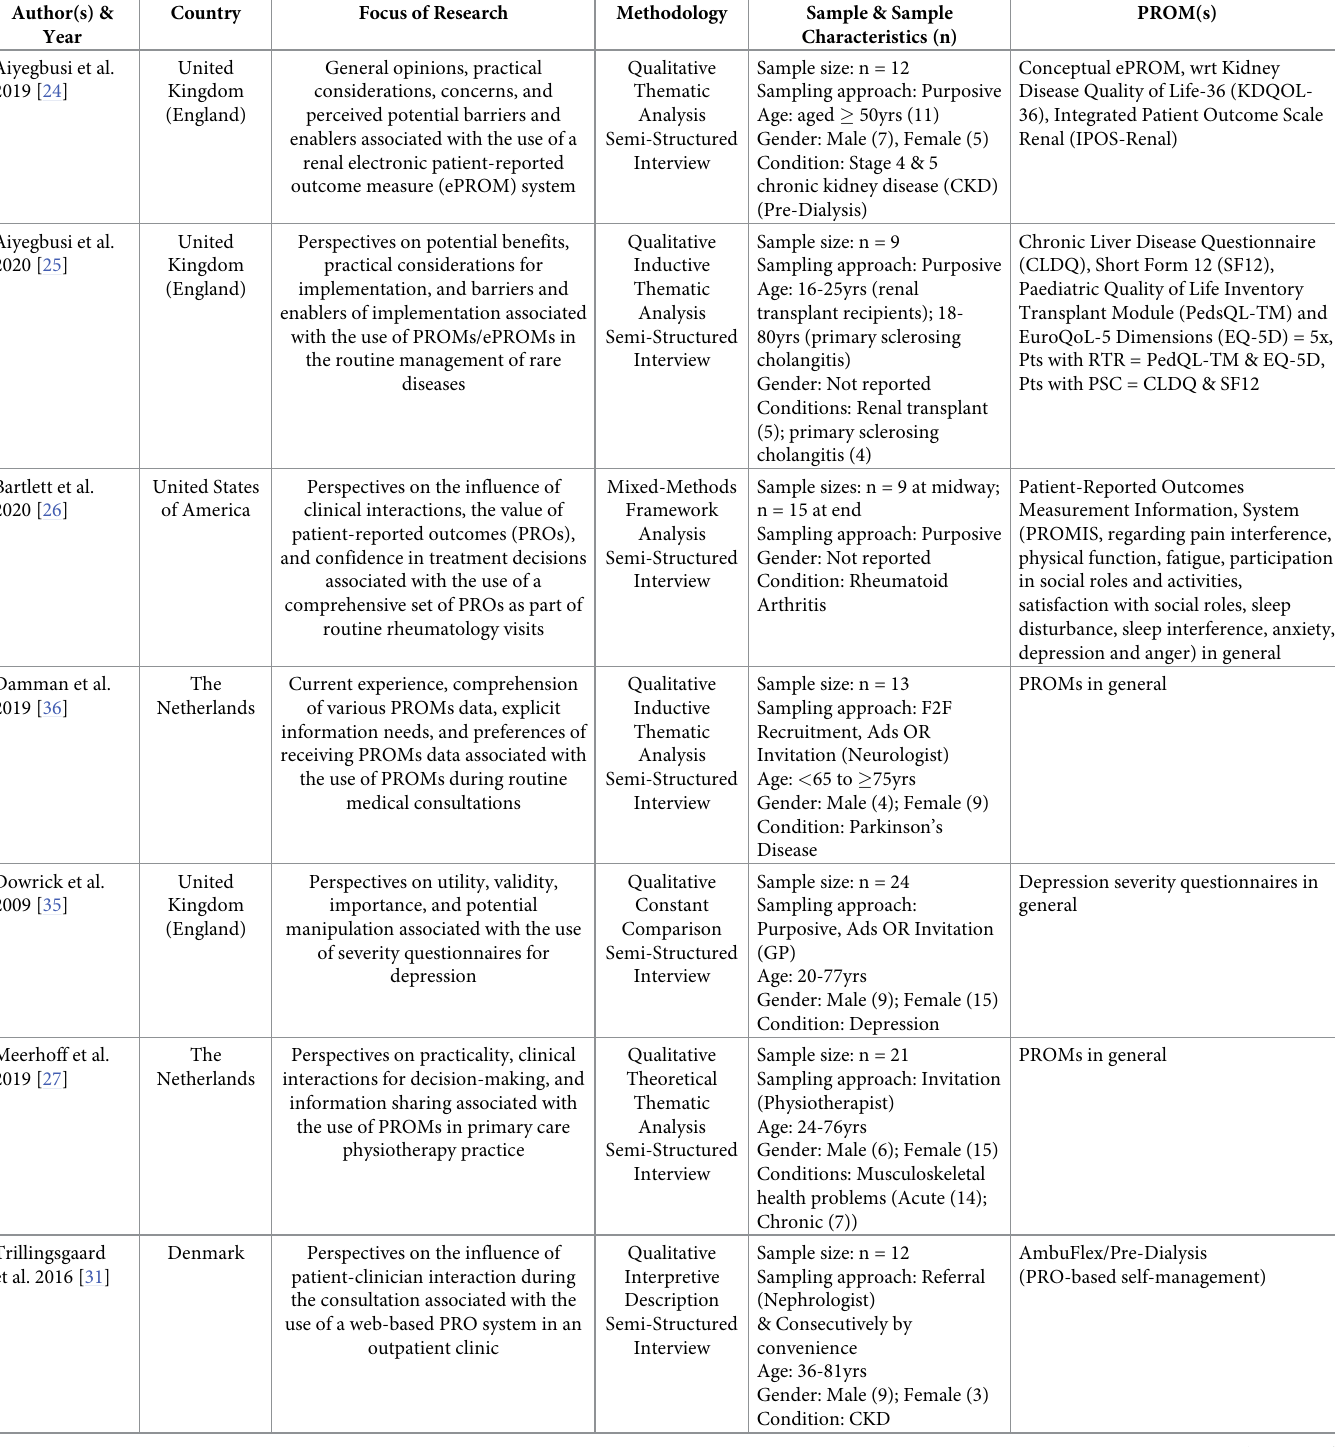
Table 2. Characteristics of the studies included in